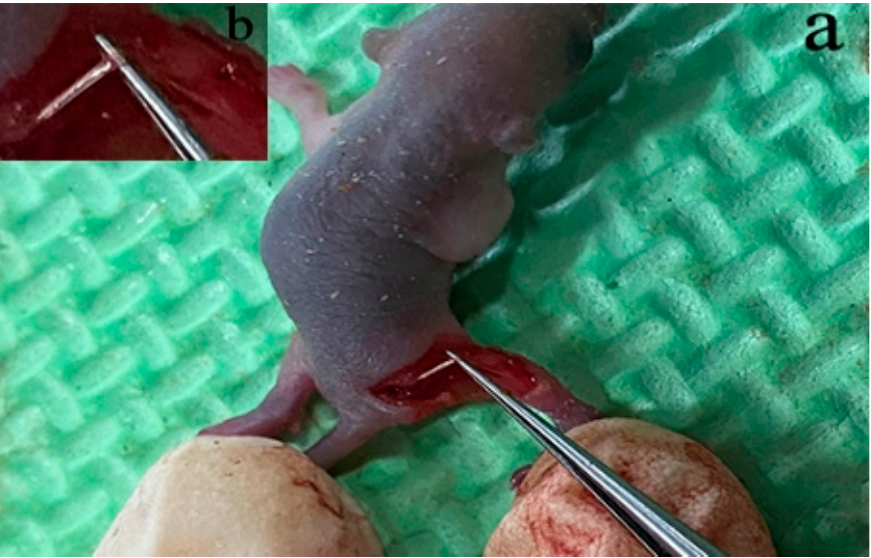
Figure 4. Locate the sciatic nerve of C57/BL6 ( a ) full image; ( b ) magnified image of the sciatic nerve.